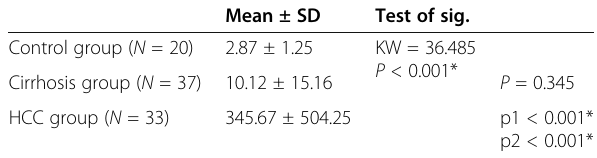
Table 3 Comparison of the AFP levels among the studied groups